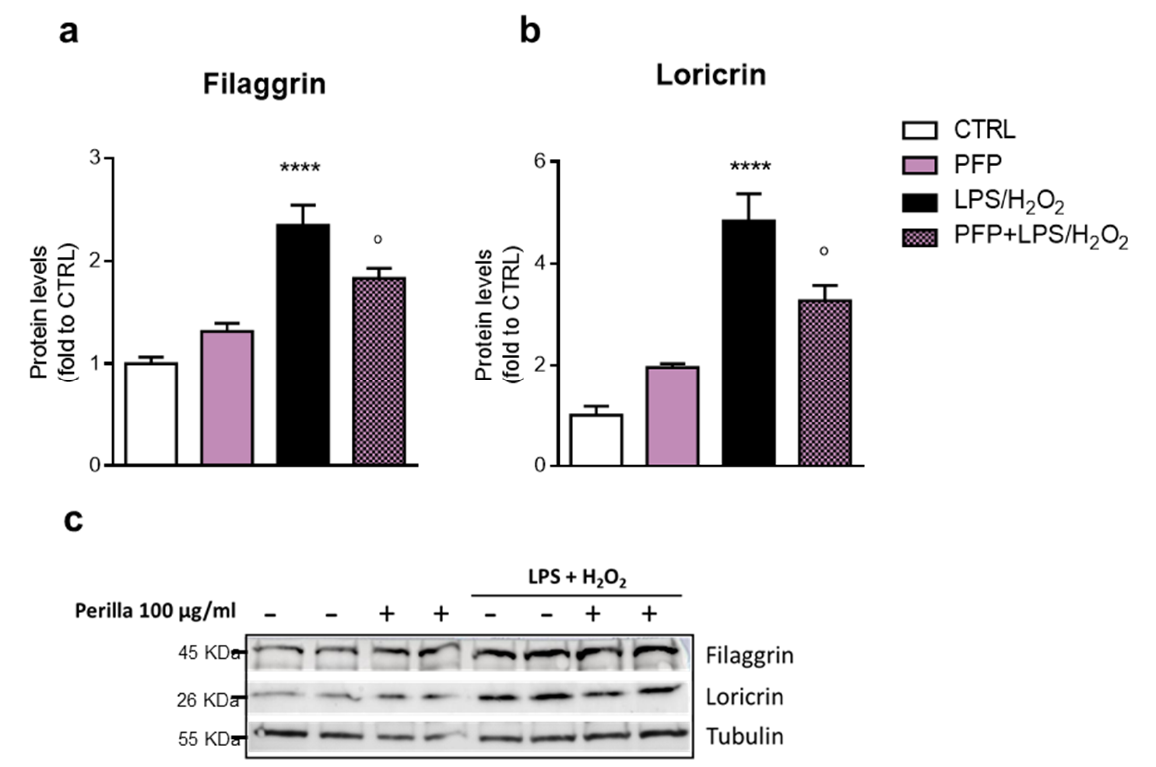
Figure 9. Western blot analysis of ( a ) filaggrin and ( b ) loricrin protein levels in HaCaT cells unstimulated (CTRL), or PFP-treated (100 µg/mL), or pre-treated with PFP for 2 h and exposed 3 h to LPS+H 2 O 2 . ( c ) Immunoblot represents protein levels of filaggrin and loricrin and the endogenous target tubulin. Each column represents mean ± SD. Data were analyzed by one-way analysis of variance followed by Tukey: **** p < 0.0001 vs. CTRL; ° p < 0.05 vs. LPS+H 2 O 2.